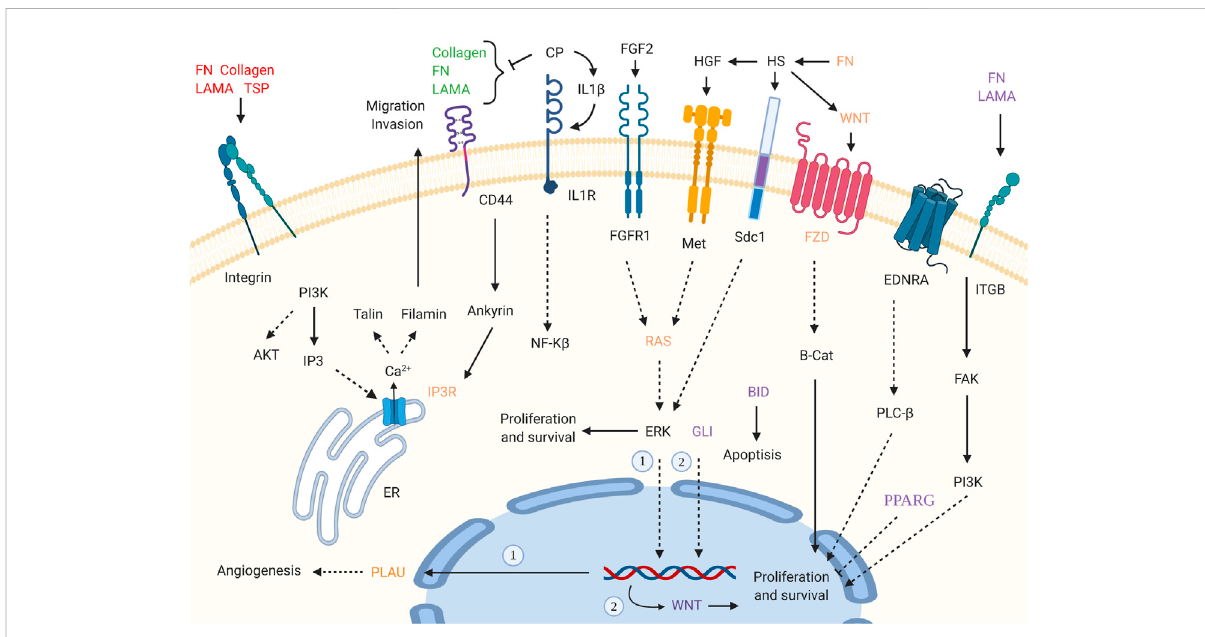
FIGURE 3 Enriched signaling pathways for URGs in male pancreatic cancer (PC) patients. Interaction of extracellular matrix (ECM) components and proteoglycans with intracellular signaling pathways, such as WNT signaling, and cell proliferation, ERK signaling, and angiogenesis has been implicated. GLI2 is also highlighted in pathways in cancer_hsa05200. ( p -value ≤ 0.05). “ Created with BioRender.com.